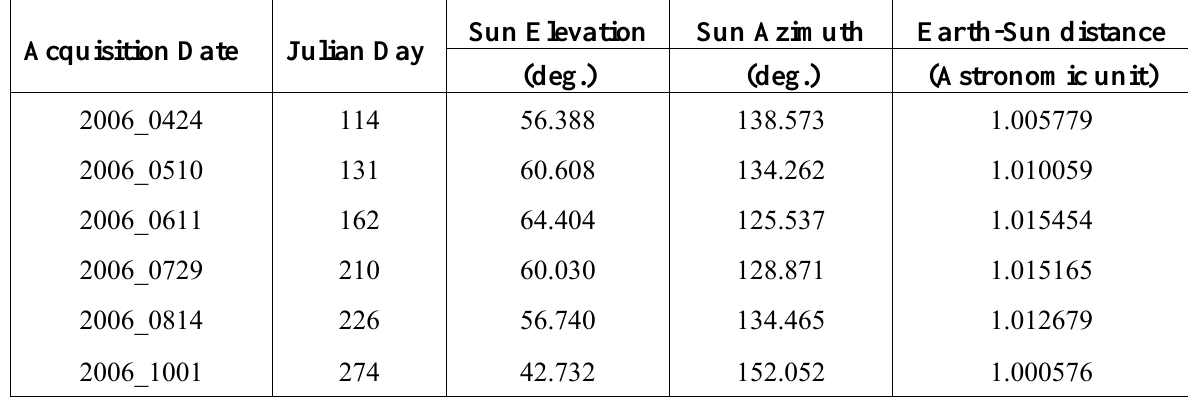
Table 1. Characteristics of Landsat ETM+ data used in this